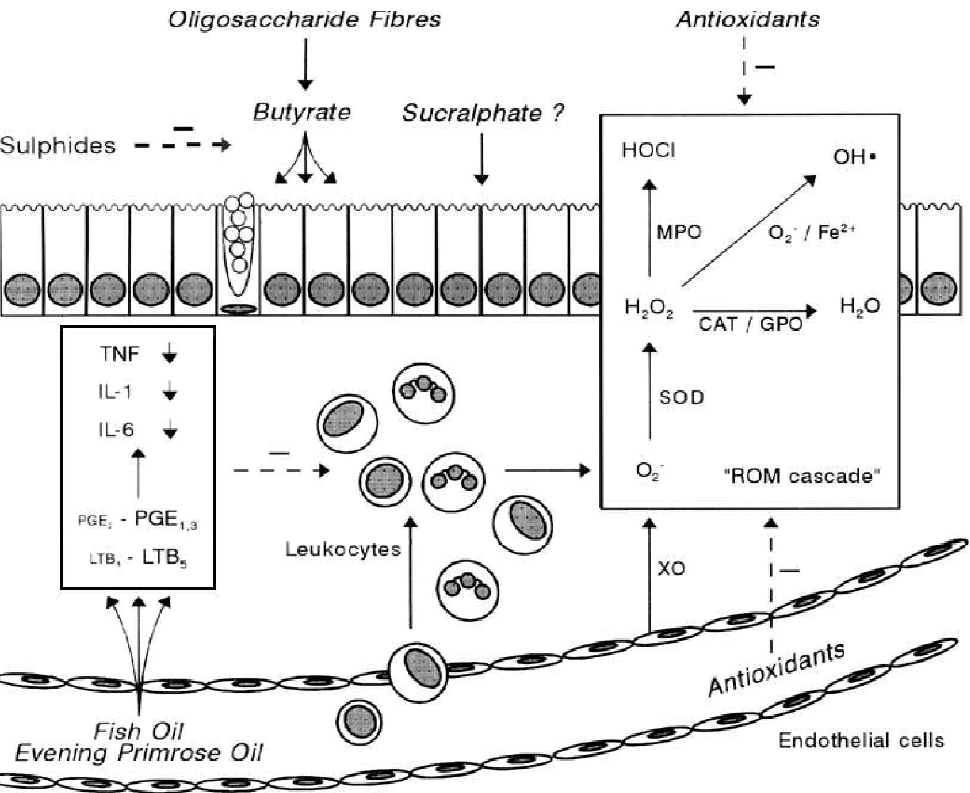
FIG. 1. Simplified schematic representation of mucosa protective and antioxidant treatment strategies in IBD. For detailed explanation, see text. CAT, catalase; GPO, glutathione peroxidase; MPO, myeloperoxidase; SOD, superoxide dismutase; XO, xanthine